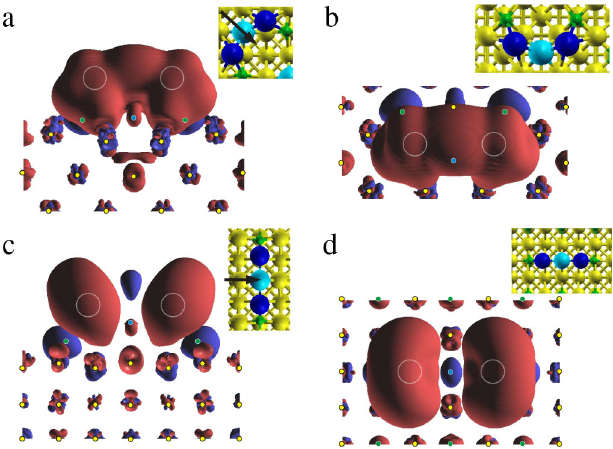
FIG. 5. Calculated spin-density isosurfaces of the modeled Gd dimers on CuN with the in-between N replaced by Ne. Such dimers are called the Gd-Ne-Gd dimer later, and both are in their ferromagnetic configuration here. (a),(b) The side and top views of the diagonal dimer. (c),(d) The side and top views of the linear dimer. For all four plots, red stands for positive magnetization, and blue for negative. The open white circles indicate the muffin- tin spheres of the Gd atoms. Stickball insets of each plot show atomic positions, with the black arrows for the side views indicat- ing the observation direction. The green, yellow, and light blue solid circles denote the positions of N, Cu, and Ne, respectively. All spin densities are plotted at the magnitude of 0 : 0005 e=a 3 0 .